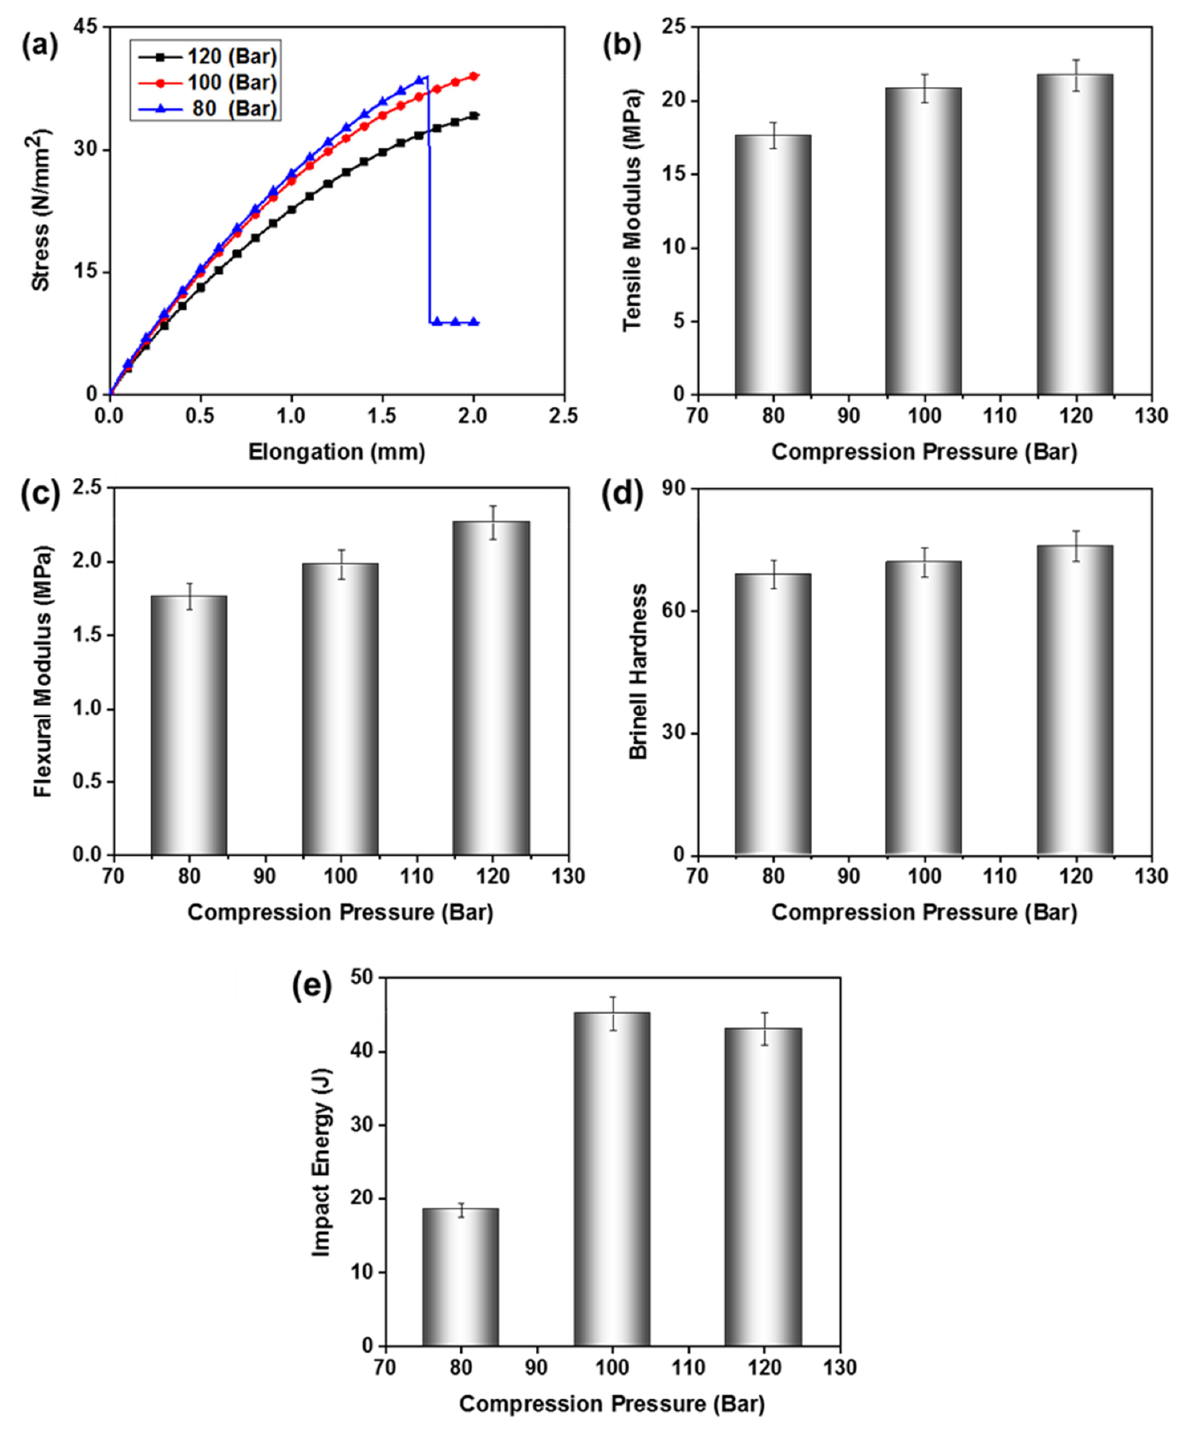
Figure 5. Effect of compression pressure on ( a ) tensile strength, ( b ) tensile modulus, ( c ) flexural strength, ( d ) Brinell hardness, and ( e ) impact resistance of TiO 2 -UP nanocomposite.